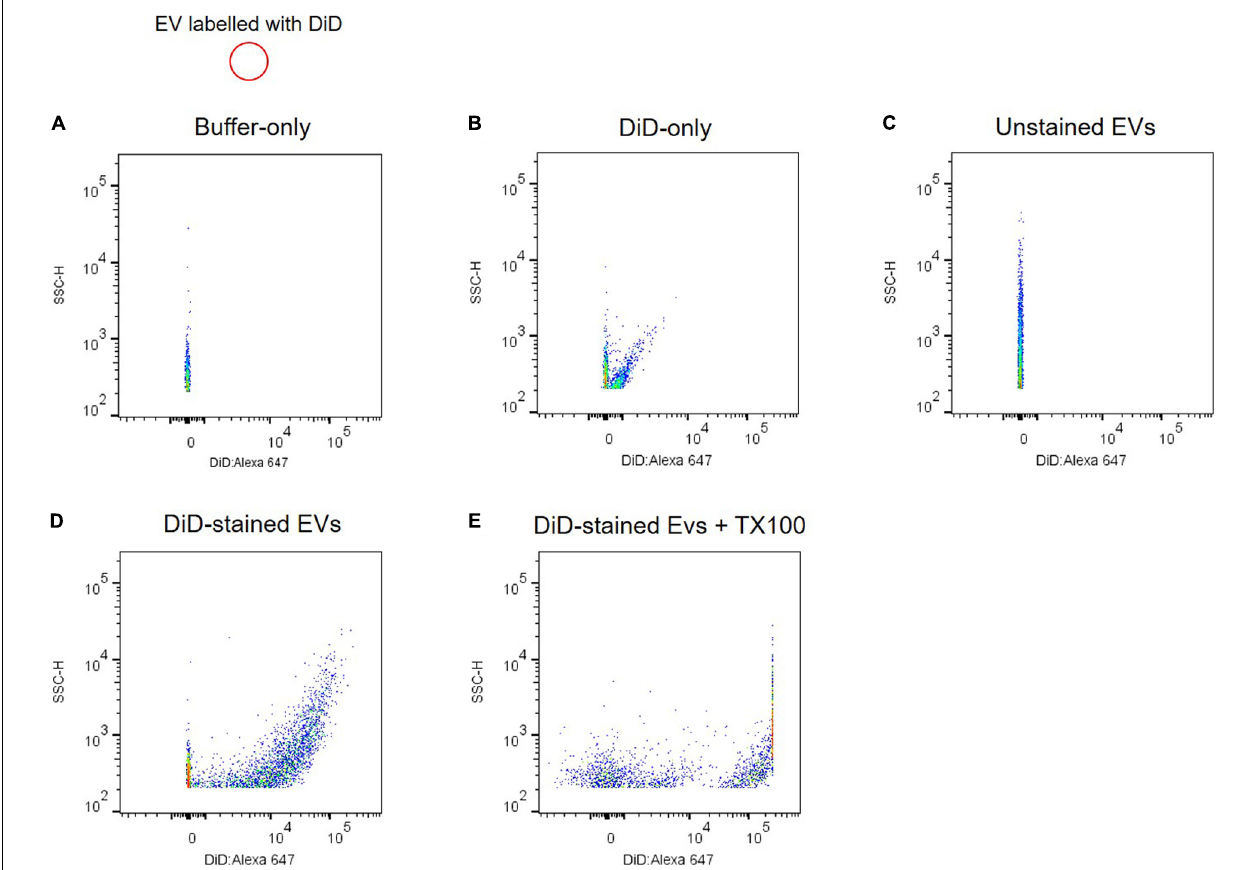
FIGURE 4 | Analyzing individual EVs using flow cytometry. Shown are dot plots of fluorescent intensity for plasma EVs labeled with DiD. Background acquisition with buffer-only control (A) and DiD-only control (B) . Plasma EV samples were unstained (C) and stained with DiD (black circle) (D) . (E) 0.1% Triton X-100 treatment disrupts light scatter and fluorescent signals of DiD-labeled